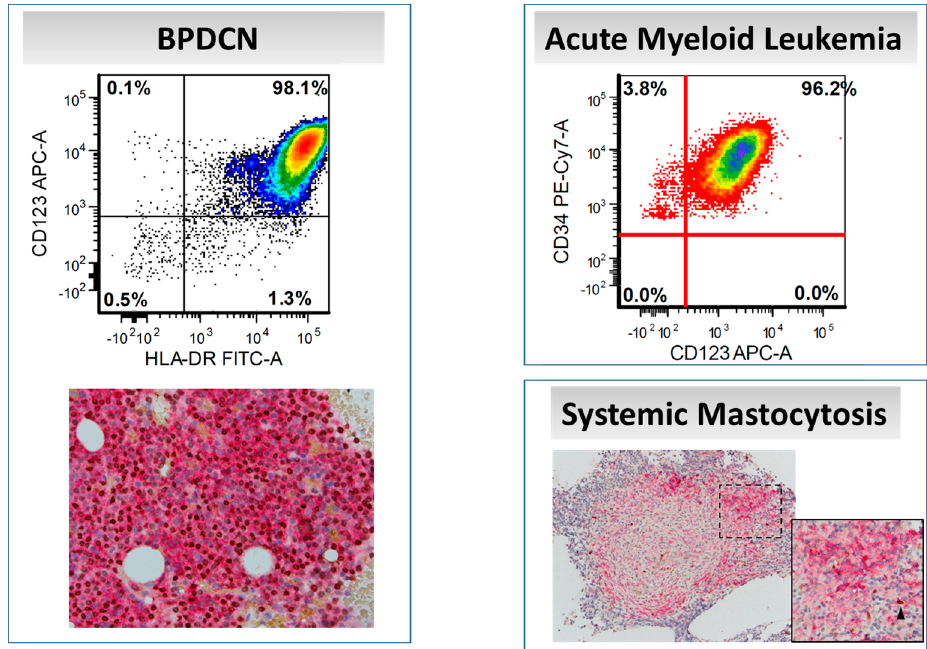
Figure 4. CD123 expression in various myeloid neoplasms, as assessed by flow cytometry and immunohistochemistry (CD123/TCF4 dual-color stain). In systemic mastocytosis, neoplastic mast cells express CD123 (red signal) without TCF4 (brown signal); a few admixed plasmacytoid dendritic cells with CD123/TCF4 coexpression can be seen (arrowhead). (Main figures at 200× magnification (inset 400×), hematoxylin counterstain).